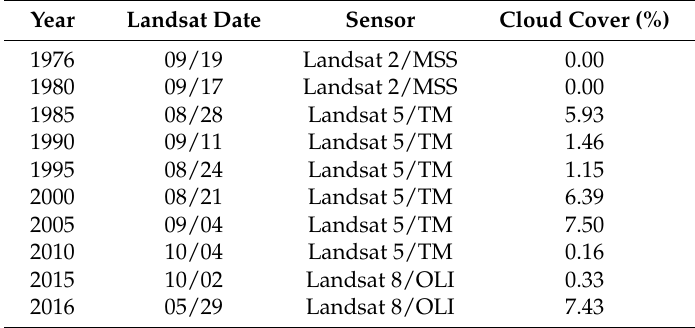
Table 1. Summary of long-term series of Landsat satellite dataset used in this study. Percent cloud cover corresponds with the date/time of remotely sensed data